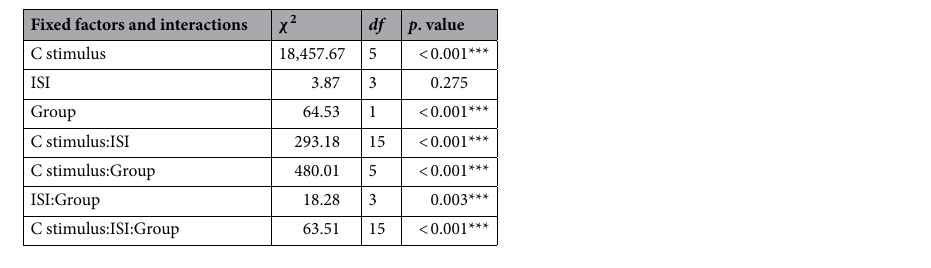
Table 5. Statistical table. Results of the II Wald χ stimulus and the Group factors with their interaction term were significant.